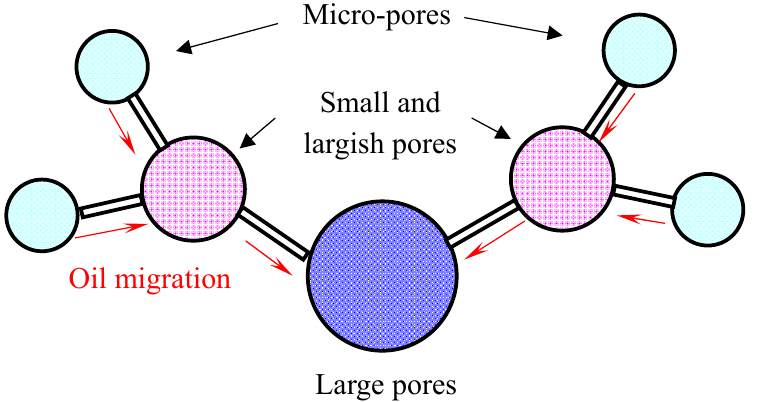
Figure 6. The schematic diagram of oil migration among the different pores.